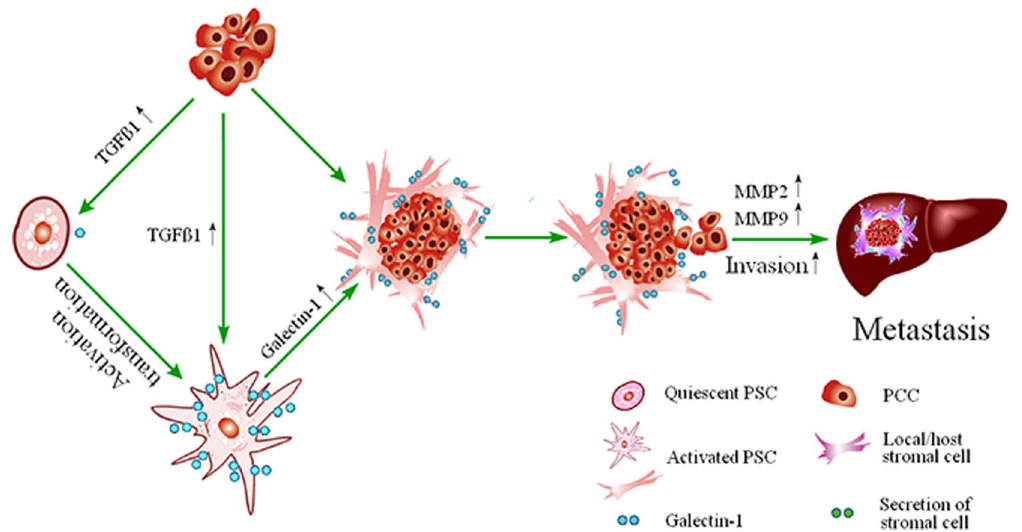
Figure 7. Mechanism of hCaPSCs derived Galectin-1 increased the invasion and metastasis of PDCA. By secreting the cytokine of TGF- b 1, PDAC cells stimulate the activation of quiescent PSCs and promote PSCs to express high level of Galectin-1. Galectin-1 has also been involved in PSCs activation, proliferation and chemokine production, which in turn stimulate the malignant potency of pancreatic cancer cells by increased both the expression of MMP2 and MMP9, and then establish a vicious cycle of mutually reinforcing mechanisms to sustain the activity of the stromal reaction and promotes the invasion and metastasis of PDCA.